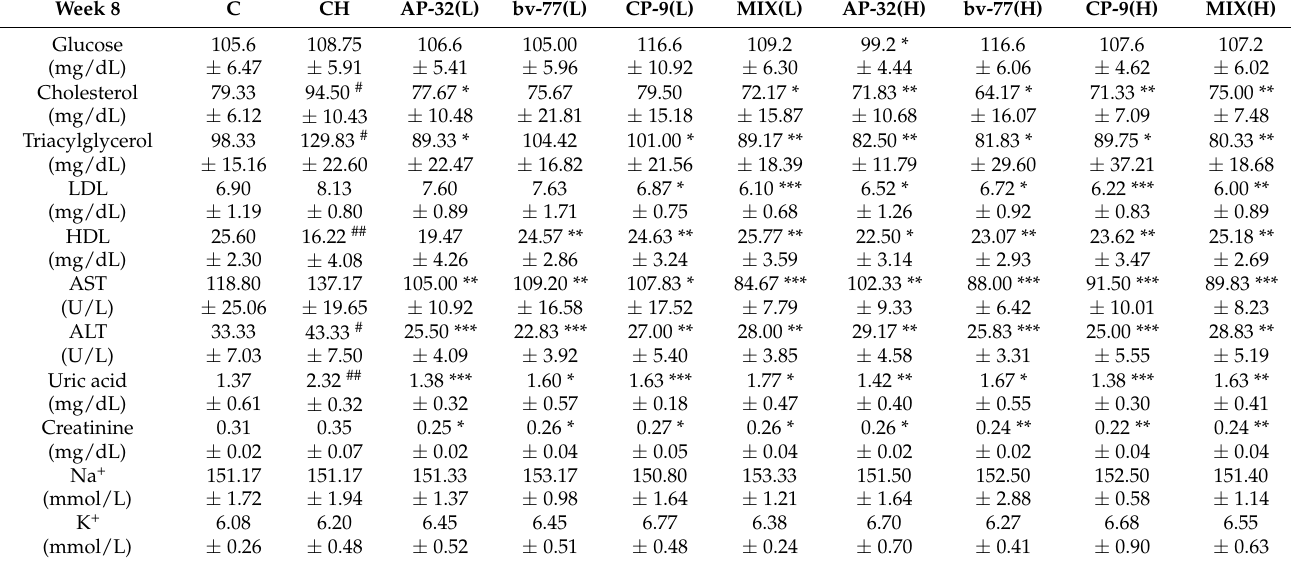
Table 2. Analyses of blood chemistry during probiotic intervention at week